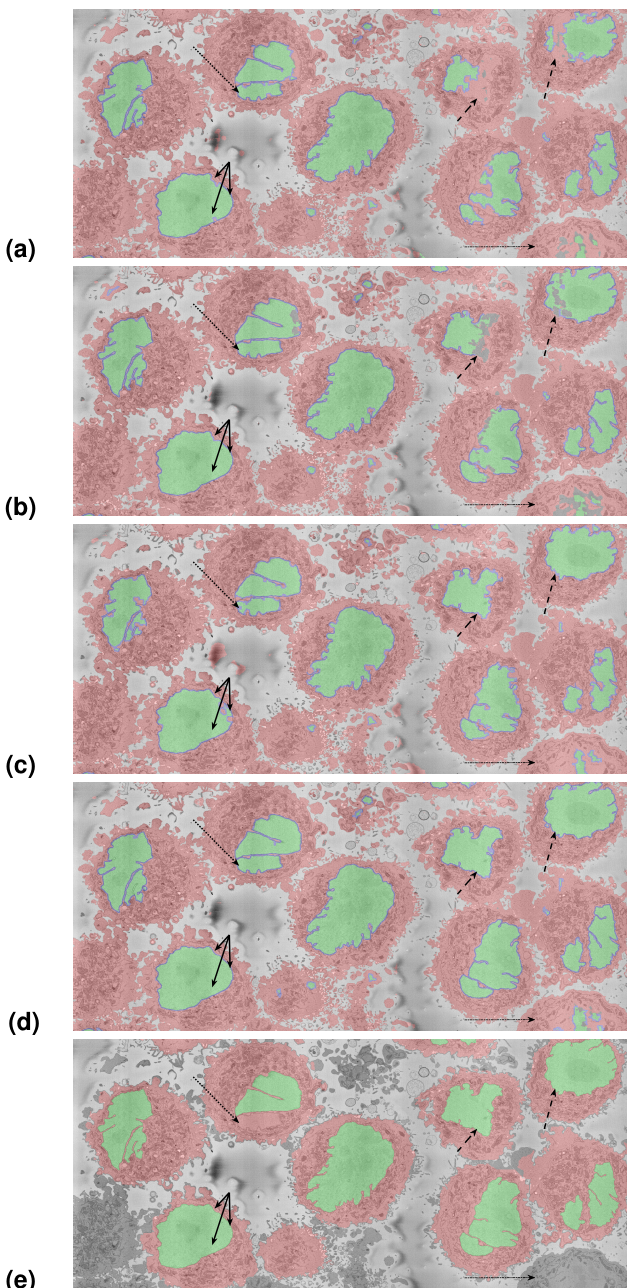
Figure 12. Segmentation of the section of interest shown in Figure 2 (red box). ( a ) U-Net trained with 36,000 patches from one cell (bottom left). ( b ) U-Net trained with 135,000 patches from one cell. ( c ) U-Net trained with 135,000 patches automatically generated with the image processing algorithm. ( d ) U-Net trained with 270,000 patches; the combination of the 135,000 of previous approaches. ( e ) Image processing (IP) algorithm. Cells are shown with red shading, nuclei are shown with a green shade, and for the U-Net results, the nuclear envelope is shown with a blue shade. It can be noticed that the segmentation of the single cell from which patches were extracted (bottom left, solid arrows) is good in all cases, with slight errors in ( c ), which is natural, as the training for this strategy originated from other cells. On the other hand, the segmentation of the top right cells (dashed arrows) is much better in ( c ) than ( a ) or ( b ), which shows the improvement provided by training in more than one cell. Whilst the image processing algorithm provides very good results, it proceeds iteratively, and unlike the U-Net, it will not process all the cells as those in the edges (dashed-dot arrow in the bottom right), and in some cases, it may miss a section of the nucleus (dashed arrow in the top